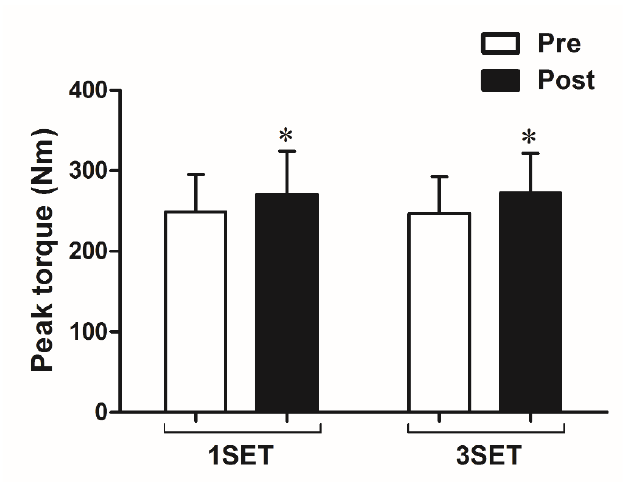
Figure 3. Isokinetic peak torque before and after the 6-wk resistance training